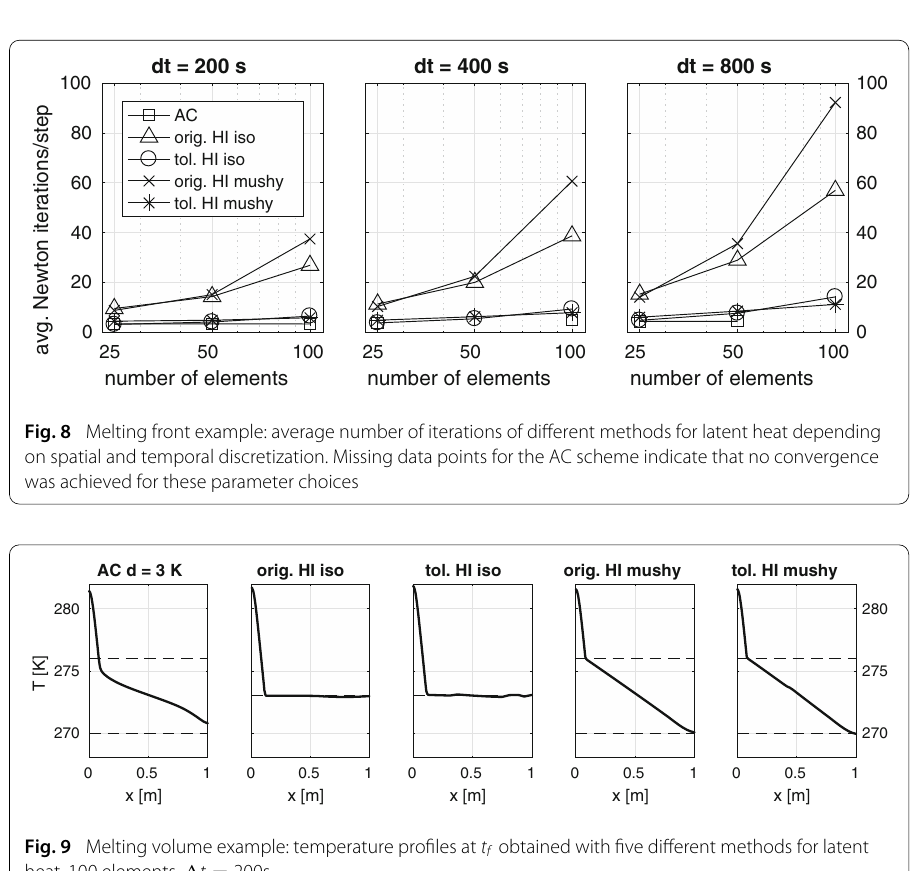
Melting volume in a 1D